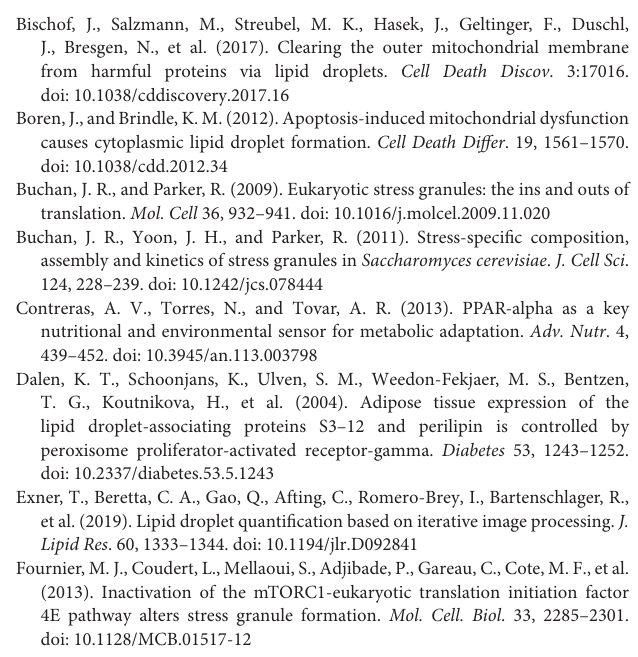
shows percentage of cells with SGs in the population and LD fluorescence intensity, mean ± SD. Pearson correlation coefficient ( r ) is 0.99. (B,C) Confocal microscopy of Bodipy and Bodipy-C12 costaining with and without (bottom row) washing. Intensity profile through the LD is shown (B) . (D) Confocal microscopy of HEK293T cell incubated with arsenite (200 µ M) or arsenite and cycloheximide (10 µ g/ml) for 90min. SG marker G3BP is detected with an antibody, Bodipy, 1 µ M was added 15min prior to the imaging. Representative confocal planes are shown; scale bar, 5 µ m. Graph shows a number of LDs per cell, mean ± SD. (E) Confocal microscopy of G3BP overexpression-induced SGs in HEK293T cells transfected with G3BP and stained with anti-TIA antibody. Representative confocal planes are shown; scale bar, 5 µ m. (F,G) Quantification of the clustering, whole cell intensity, and the size of the LD in U2OS (WT and G3BP1/2 KO) cells during arsenite treatment, refer to Figure 2J , mean ± SD, ∗ P < 0.01. Supplementary Figure 3 | (A) Confocal microscopy of SG and LD formation during oleic acid (OA) treatment. HEK293T cells were treated with the indicated amounts of OA for 24h before the imaging. SGs are visualized with an endogenous PABPC1-DDR2. LDs are stained with Bodipy. (B) PPAR activation leads to mTOR inactivation. Cells were incubated with PPAR activators (rosiglitazone, clofibrate, and GW501516, 100 µ M) for 3h. mTOR activity was assessed by antiphopho-4EBP and microscopy of cells during PPAR activators treatment; scale bar, 5 µ m. (C) Immunofluorescence showing SG marker localization to the PABPC1-DDR2 inclusions during PPAR activation. PABPC1-DDR2 cells were treated with clofibrate, rosiglitazone, and GW501516 (100 µ M) for 1h. Cells were fixed and stained with anti-TIA1 and anti-G3BP antibodies. Hoechst (10 µ g/ml) was used to stain the nucleus 15min prior to imaging. Confocal planes are shown; scale bar 5 µ m. (D) SG formation timeline during PPAR activation showing fatty acid accumulation. Cells expressing CRISPR/Cas9-tagged PABPC1-DDR2 were incubated with rosiglitazone, clofibrate, and GW501516 (100 µ M) for indicated amounts of time, LD dye (Bodipy-C12, 1 µ M) was added 30min prior to the imaging together with Hoechst (10 µ g/ml). Representative confocal images are shown. Arrows indicate SGs; scale bar, 5 µ m. (E) SG formation in SHSY-5Y cells. Cells were treated with arsenite (100 µ M) or 2-BP (200 µ M) for 1h and fixed. Stress granules marker (G3BP and TIA1) were visualized using immunostaining. Representative confocal planes are shown; arrowheads indicate SGs; scale bar, 5 µ